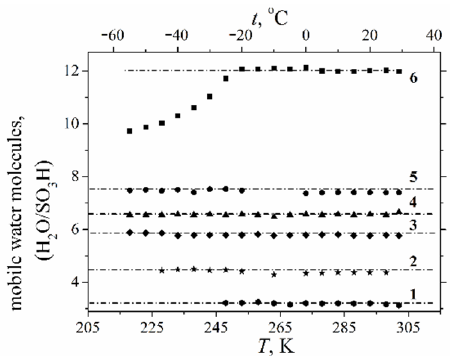
Figure 16. Dependences of the mobile water molecule amount in the acidic form of the Nafion 117 membrane on temperature at different water contents: (1) λ = 3.2 ± 0.4; (2) λ = 4.4 ± 0.4; (3) λ = 5.8 ± 0.4; (4) λ = 6.4 ± 0.4; (5) λ = 7.4 ± 0.4; (6) λ = 12 ± 0.4. Reprinted with permission from Ref. [41]. Copyright © 2022 Springer-Verlag GmbH Austria, part of Springer Nature.